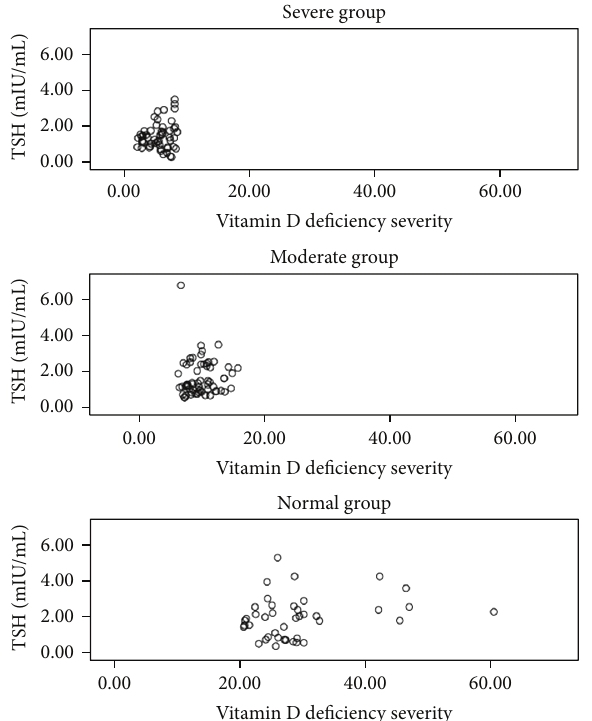
Figure 2: The correlation between anti-TG and vitamin D in each group. The cut-off value for negative anti-Tg concentration is < 6IUmL −1